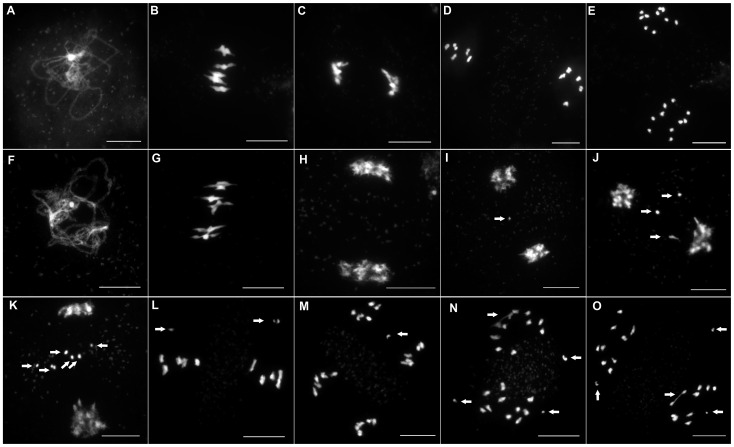
Male meiosis in wild-type and in Atmcm8.Male meiosis is shown (A–E) in wild type and (F–O) in Atmcm8. Chromosome spreads at (A and F) pachytene, (B and G) metaphase I, (C and H–K) end of anaphase I, (D and L) metaphase II, (E and M–O) anaphase II, using DAPI staining. Fragments and chromosome bridges are indicated with arrows. Bar, 10 µm.